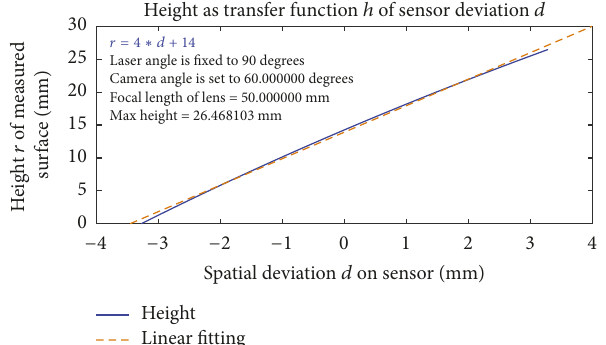
Figure 3: Transfer function relating surface level and spatial deviation on image plane.